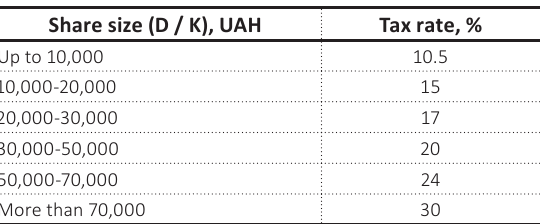
Table 5. Personal income tax contingent rates